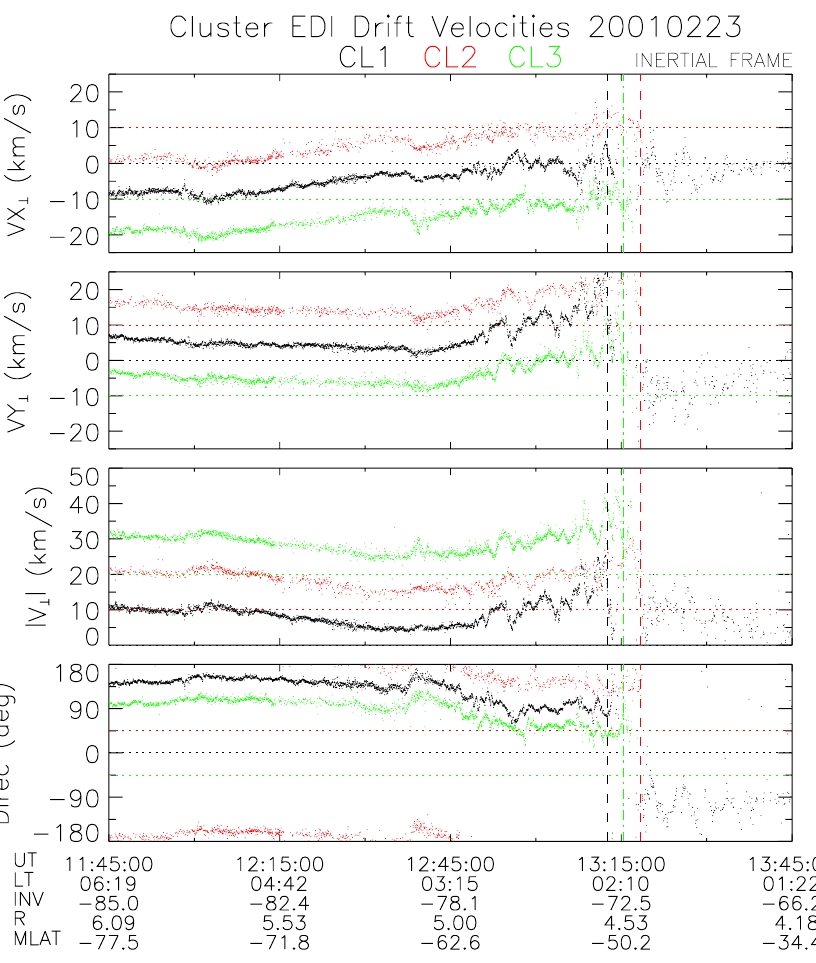
Fig. 5. Drift velocities for the 23 February southern hemisphere crossing from the polar cap into the high-latitude plasma sheet. Same format as Fig. 4. Vertical dashed lines show when the spacecraft encountered the intense 1keV electron boundary (see Fig.